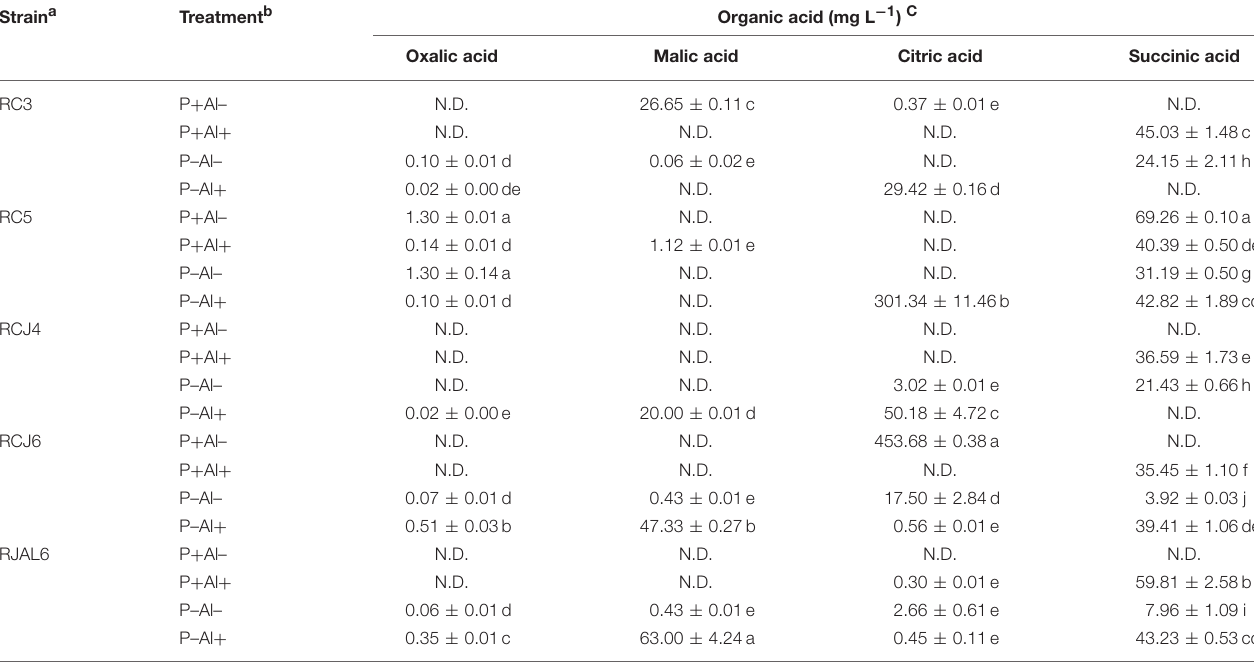
TABLE 1 | Organic acid secretion by five selected phosphobacteria strains grown in mineral culture media (MCM) with contrasting P and Al concentrations. Strain